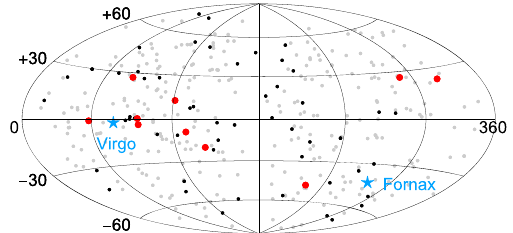
Fig. 1 Objects with anomalous hardenings in VHE (red circles) together with other objects from the TeVCat (black dots) and 3FHL (gray dots) samples in the celestial sphere (supergalactic